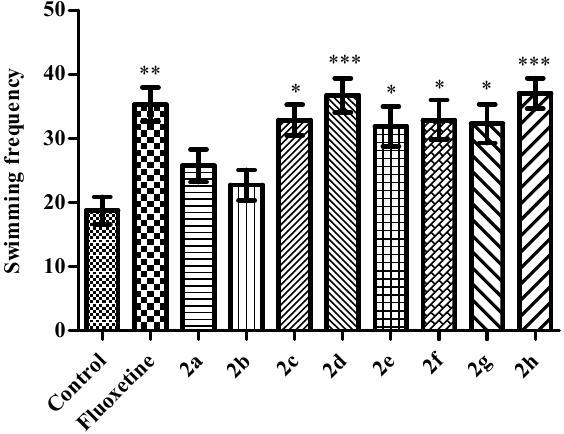
Figure 4. The effects of the test compounds ( 2a – 2h ) and fluoxetine on the swimming frequencies of the mice in MFST. Significant differences against control group, * p < 0.05, ** p < 0.01, *** p < 0.001. Values are presented as mean ± SEM, ( n = 7).